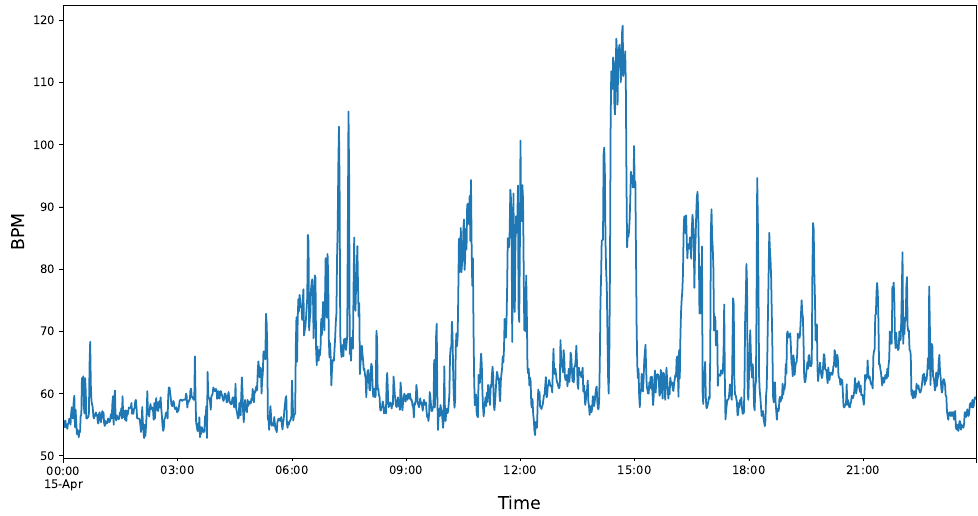
Figure 1. Heart rate of an individual from the Fitbit dataset for one